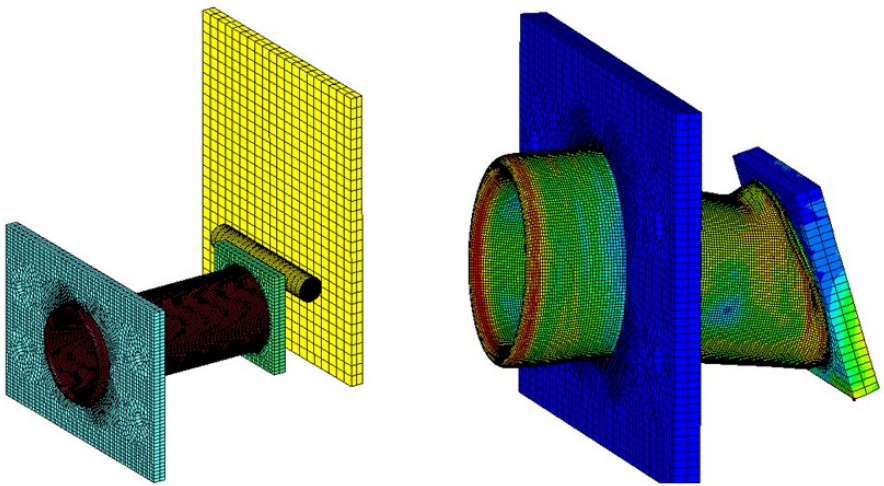
Figure 13. Eccentric loading of the EAC at the edge ( e = 32 mm). Adapted with permission from [15], IST, 2021.